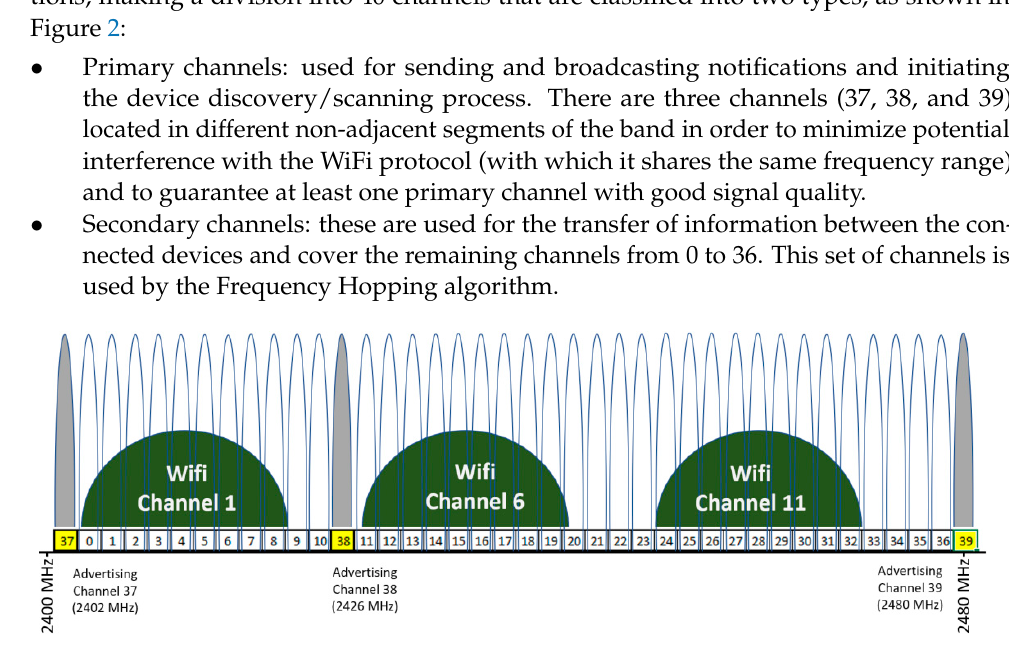
Figure 2. Bluetooth Low Energy channel spectrum.